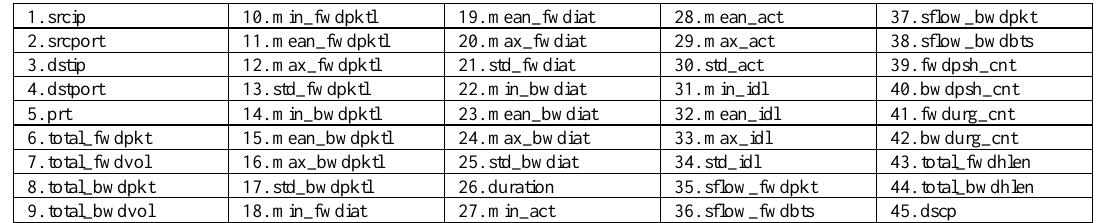
Table 1. Extracted